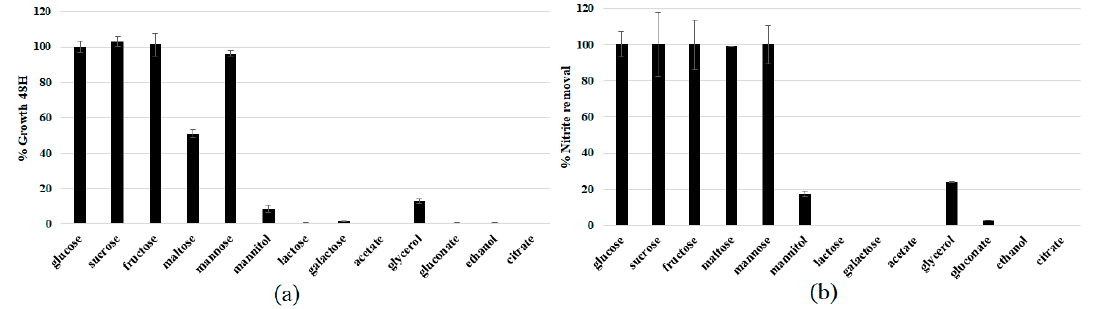
Figure 3. R. diobovata DSBCA06 relative 48 h growth in YNB + 10 mM NaNO 2 ( a ); using different carbon sources at (2% w / v ), and corresponding nitrite removed ( b ).